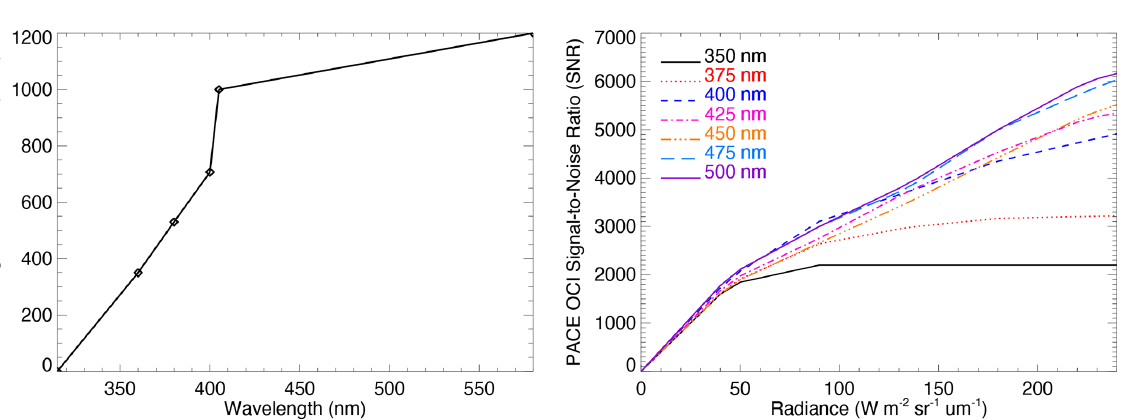
Figure 1. (a) The specified GLIMR SNR, which is assumed to be constant with radiance, and (b) the PACE OCI SNR as a function of wavelength and radiance based on measurements provided by the instrument team.